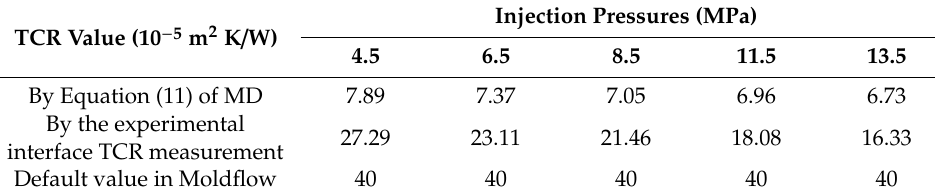
Table 2. TCR values in the micro-injection moulding simulation.